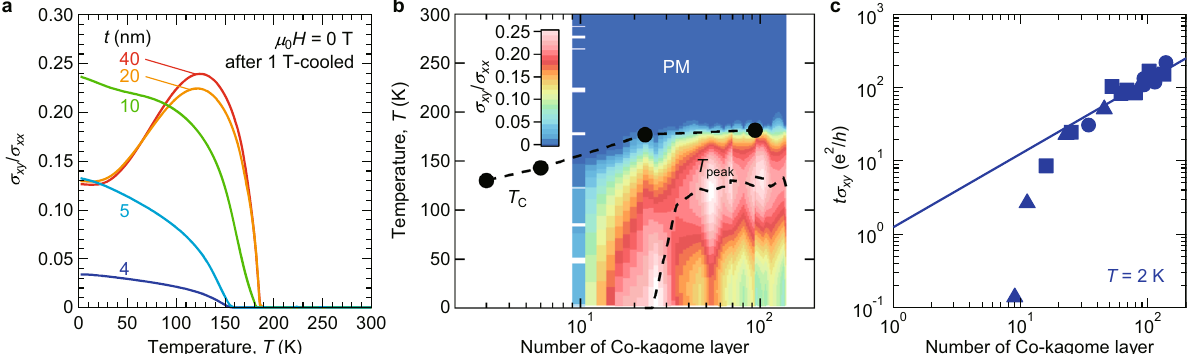
Fig. 4 Phase diagram of Co 3 Sn 2 S 2 fi lms for magnetic WSM. a T dependence of σ xy / σ xx measured for fi lms with t = 40, 20, 10, 5 and 4 nm (fabricated with the target B) at zero fi eld after fi eld-cooled at μ 0 H = 1 T. b Contour plot of σ xy / σ xx as a function of T and the nominal number of Co-kagome layers in the Co 3 Sn 2 S 2 fi lms (PM: paramagnetic). The nominal number of Co-kagome layers was calculated using the c axis length determined by XRD (Supplementary Fig. 1). T C (Fig. 1e) and T peak are included for comparison. c Sheet Hall conductance t σ xy at T = 2 K as a function of the number of Co-kagome layers. The solid line indicates the fi tting result using a linear relation of log t σ xy ¼ a þ log N Co